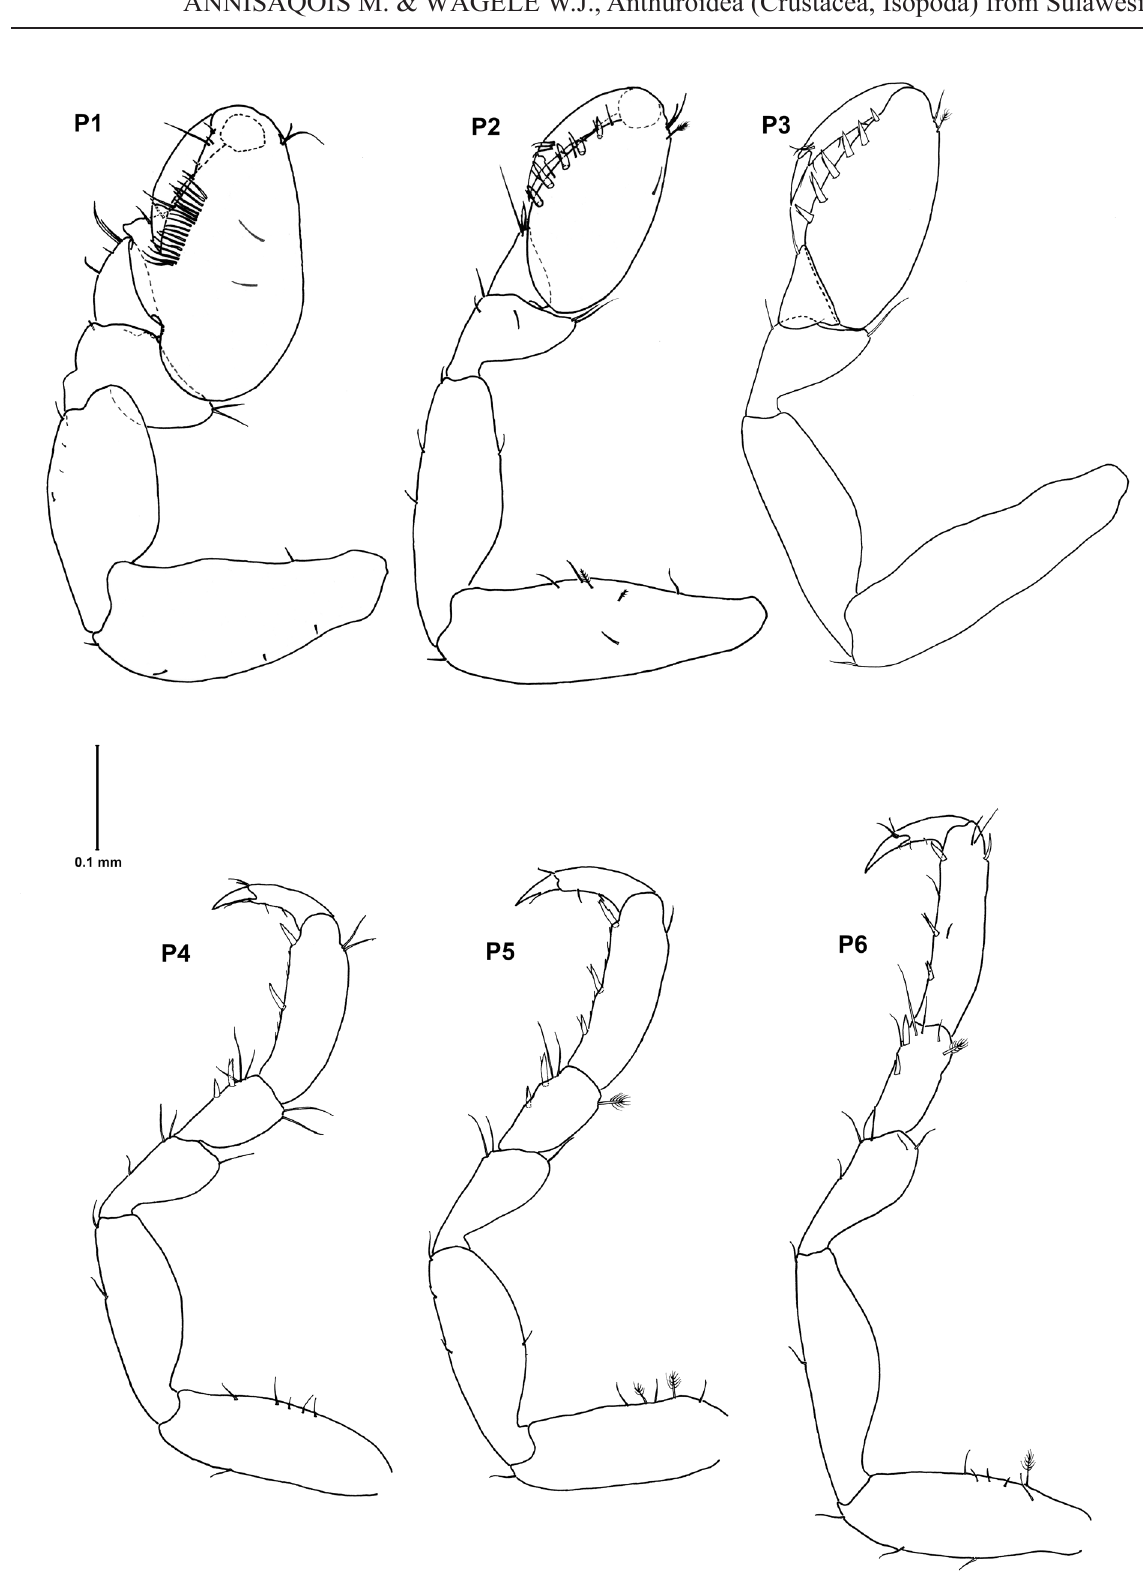
Fig. 28. Colanthura gerungi sp. nov., ♂, holotype (MZB Iso 109). Abbreviation: P1–P6 = pereopods